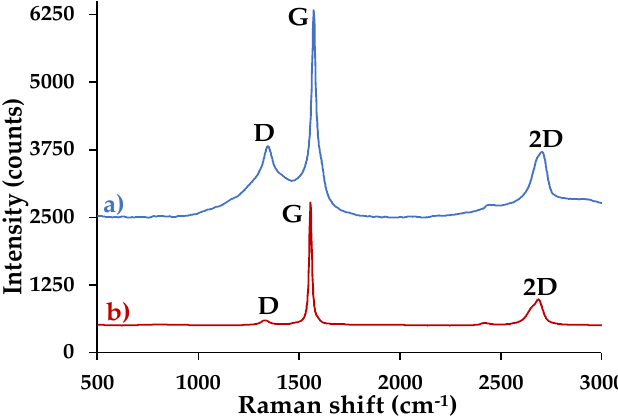
Figure 1. Raman spectrum of graphite: ( a ) before cleaning and ( b ) after cleaning.